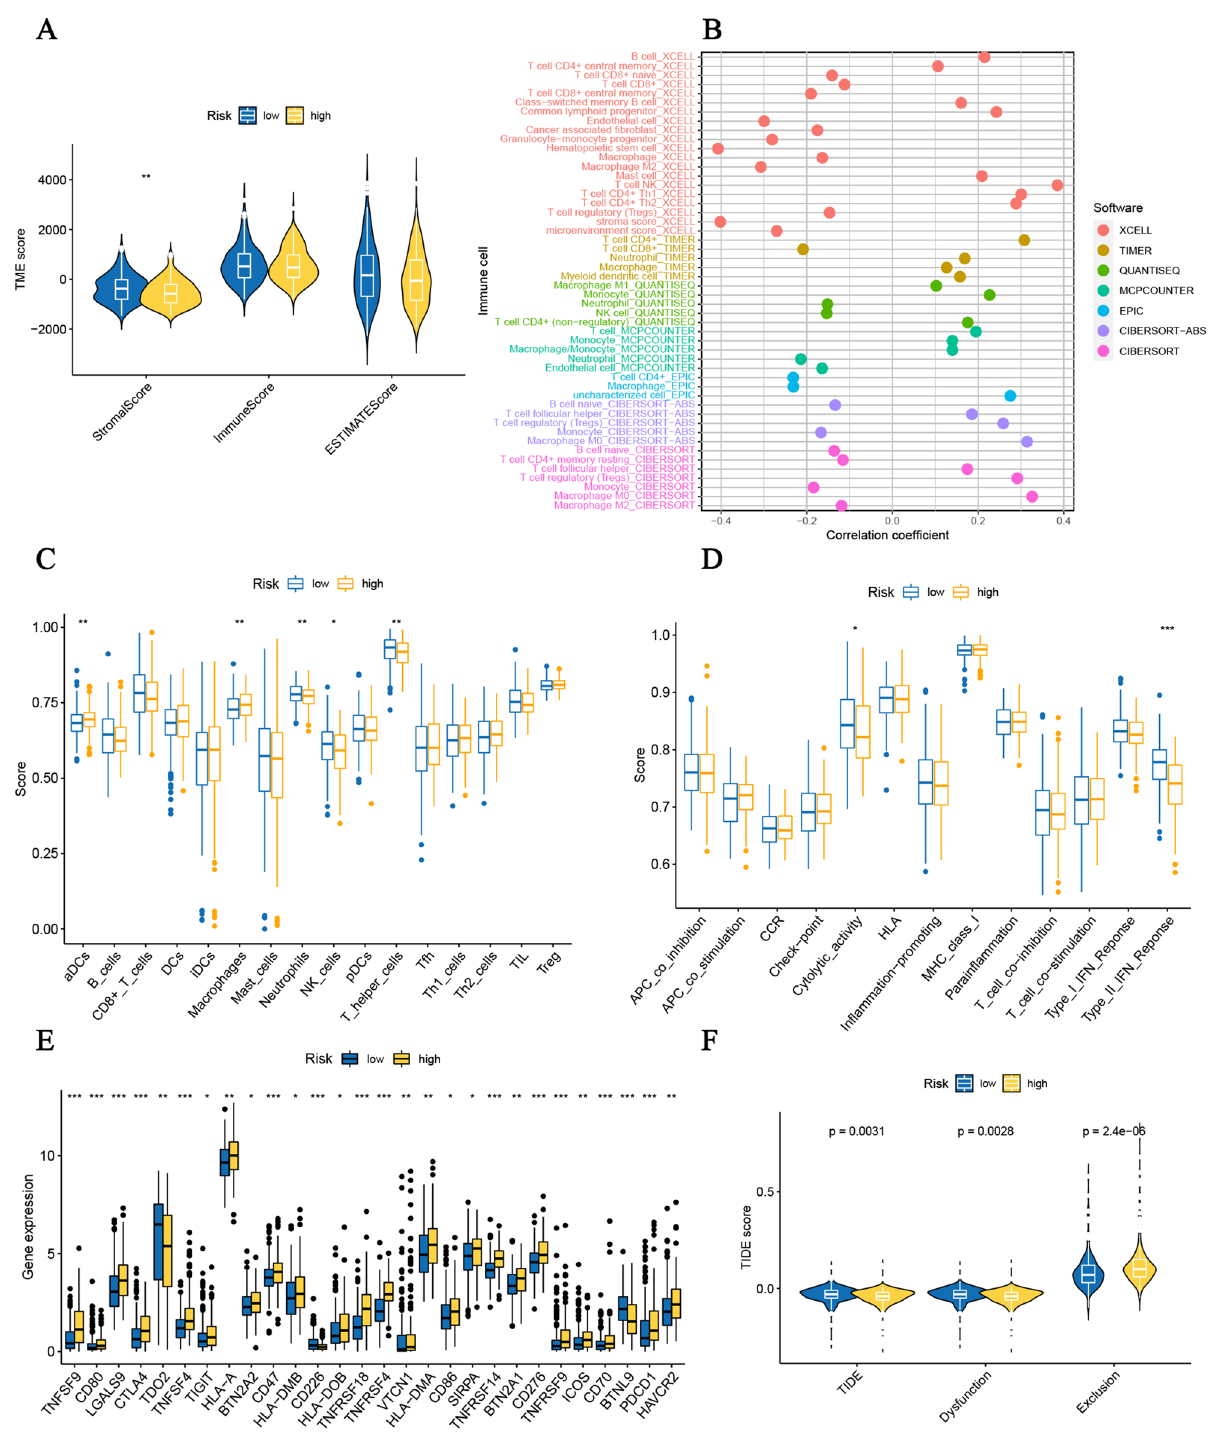
Figure 7. Immune-related analyses of cuproptosis ‐ related ICGs prognostic signature. ( A ) TME score prediction. ( B ) The immune cell infiltration by multiple methods. The correlation between the predictive signature and ( C ) 16 immune cells and ( D ) 13 immune-related functions. ( E ) The relationship between prognostic signature and immune checkpoints. ( F )TIDE score prediction. * p < 0.05; ** p < 0.01; *** p <